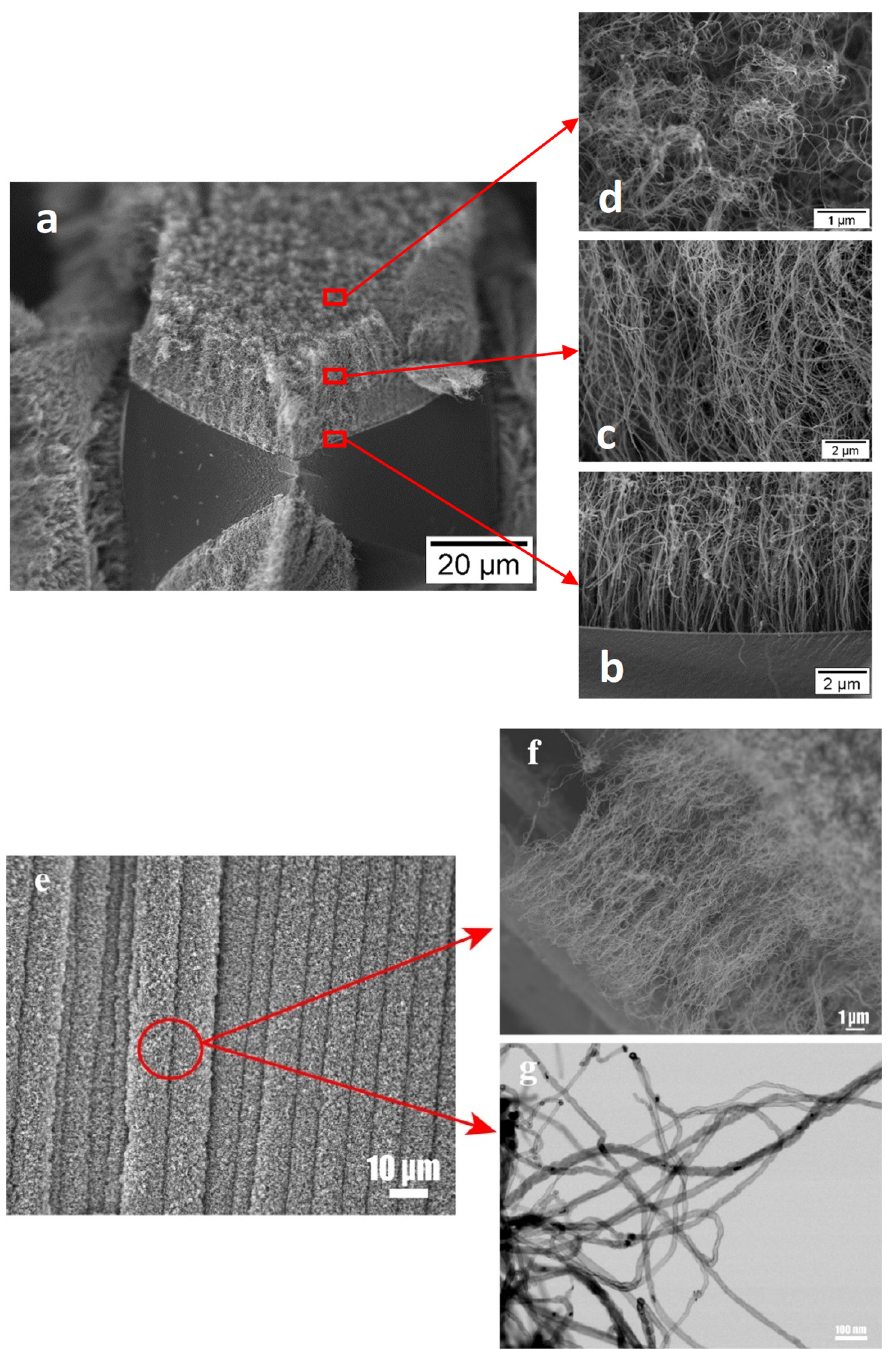
Figure 5. Schematic of hierarchical structure, where carpet-like arrays of CNT are strongly attached to a porous carbon substrate. Carbon substrate can be flexible carbon fiber cloth ( right-top ), reticu- lated vitreous carbon foam ( right-middle ) or micro cellular carbon foam ( right-bottom ).